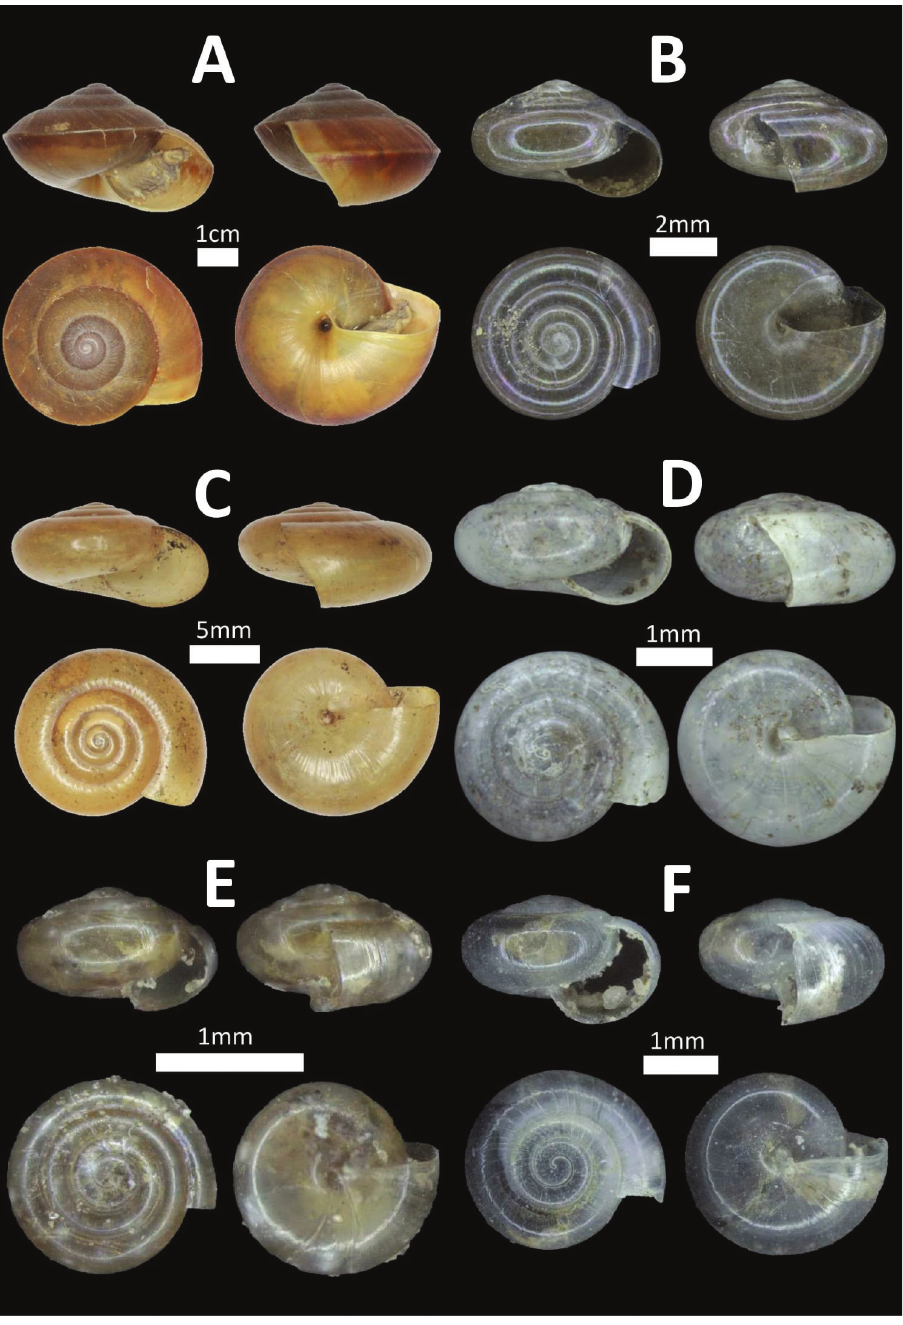
Figure 11. FAMILY ARIOPHANTIDAE. A Hemiplecta humphreysiana (BOR/MOL 7870) B Macrochla- mys tersa (BOR/MOL 10299) C Macrochlamys indica (BOR/MOL 12490) D Microcystina striatula